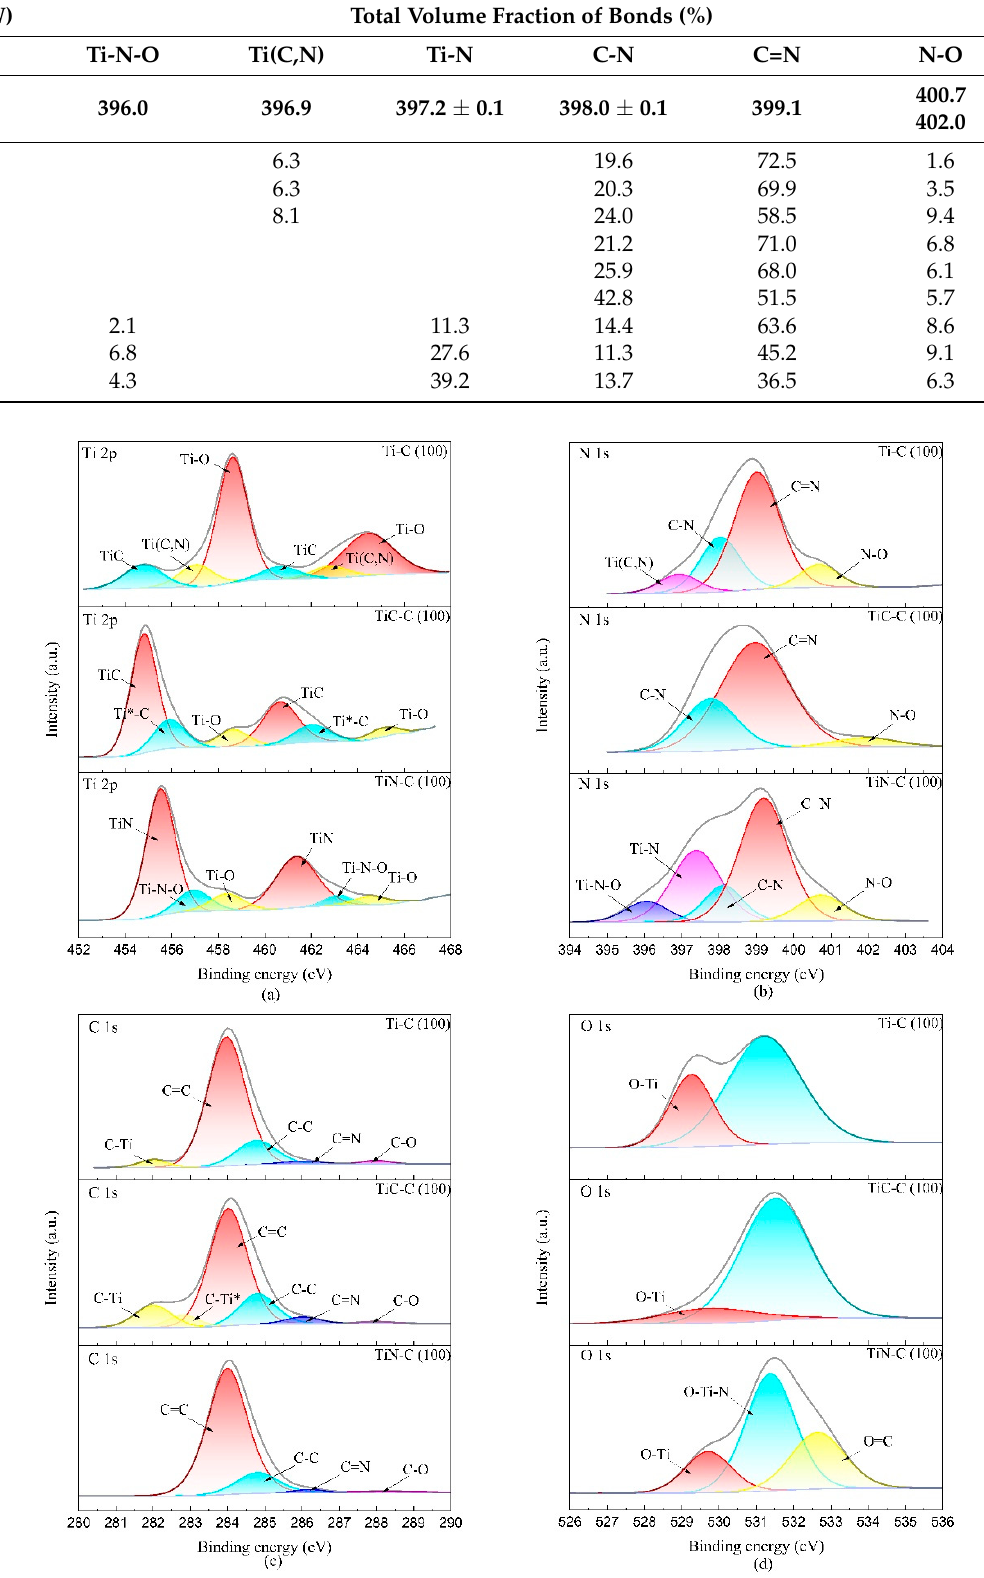
Table 4. XPS analysis results of N 1 s.